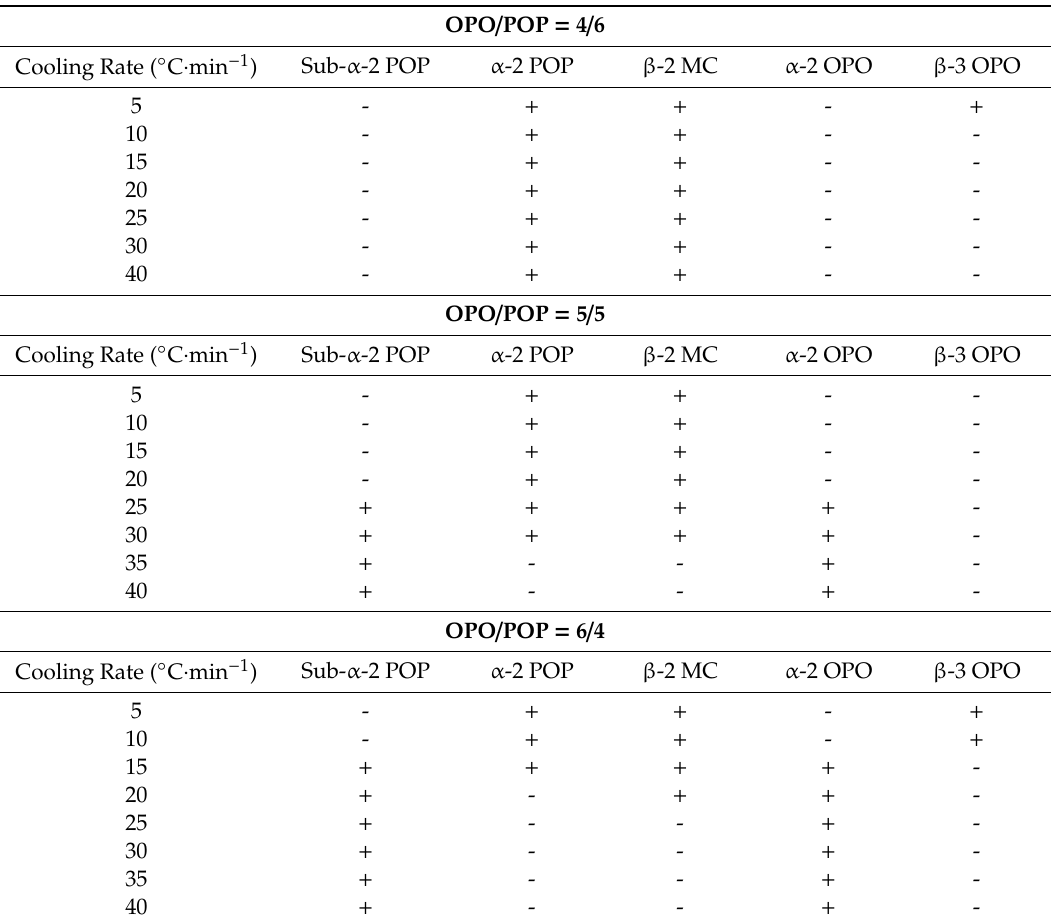
Table 2. Polymorphs observed at SR-TXRD